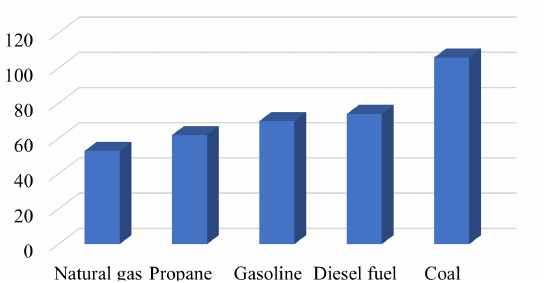
Figure 1. General relationship of CO 2 produced by common combustion fuels. (Original figure using U.S. Energy Information Administration data.)